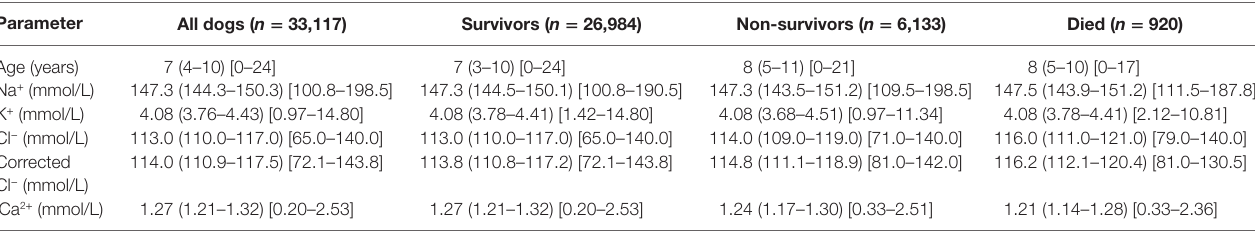
Table 1 | Summary electrolyte data.